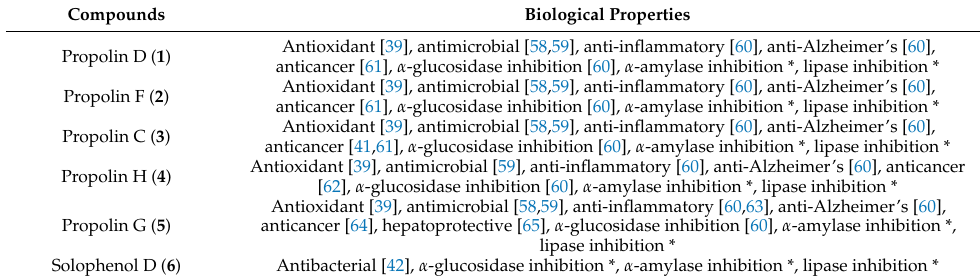
Table 3. An overview of the biological properties of the six compounds isolated from the Queensland